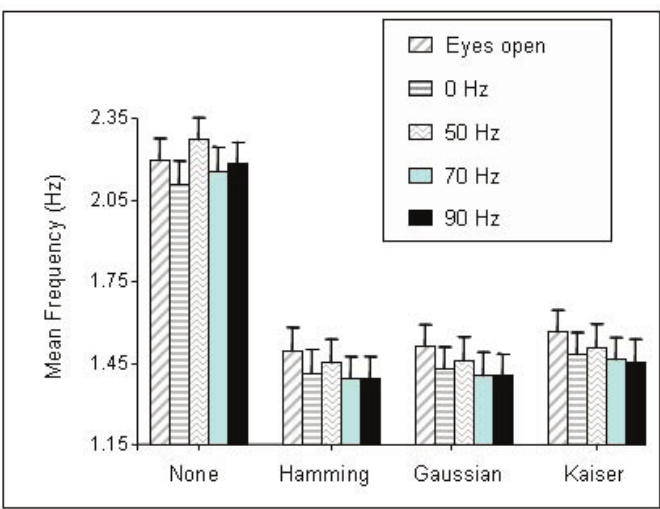
Figure 9. Mean frequency estimation using Fourier–Bessel Expansion for 100-point win- dows (ML): (a) No window; (b) Hamming window, (c) Gaussian window ( (cid:5) D 2:5 ), (d) Kaiser window ( ˇ D 8